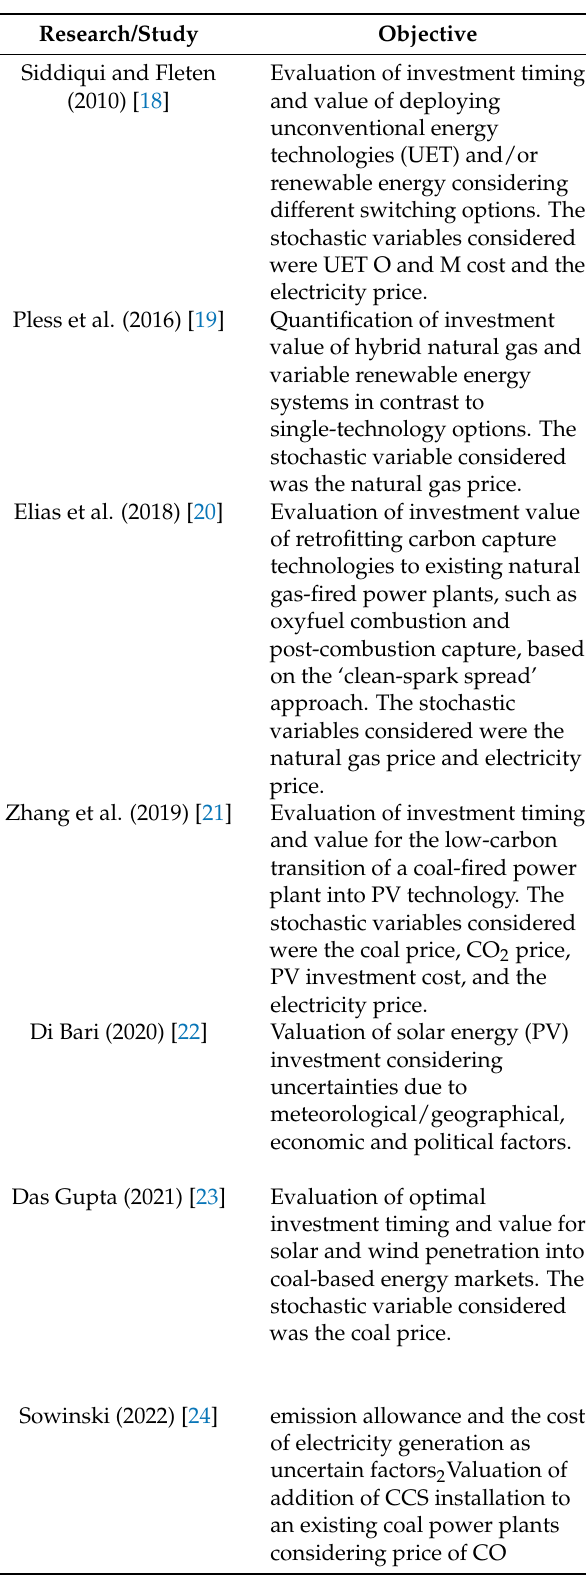
Table 1. Comparative summary of valuation methodologies for the transition towards low-carbon energy based on the Real Options